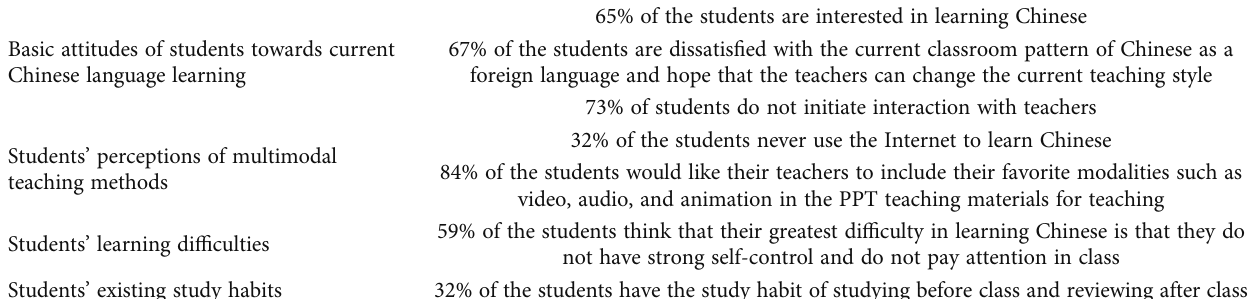
Table 1: Result of questionnaire before applying the multimodal teaching model.